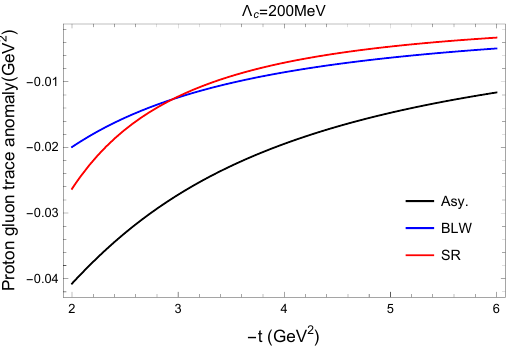
Figure 8. h P 0 | β ( g ) F 2 | P ↓ i with respect to ( − t ) within different models of nucleon ↑ 2 g